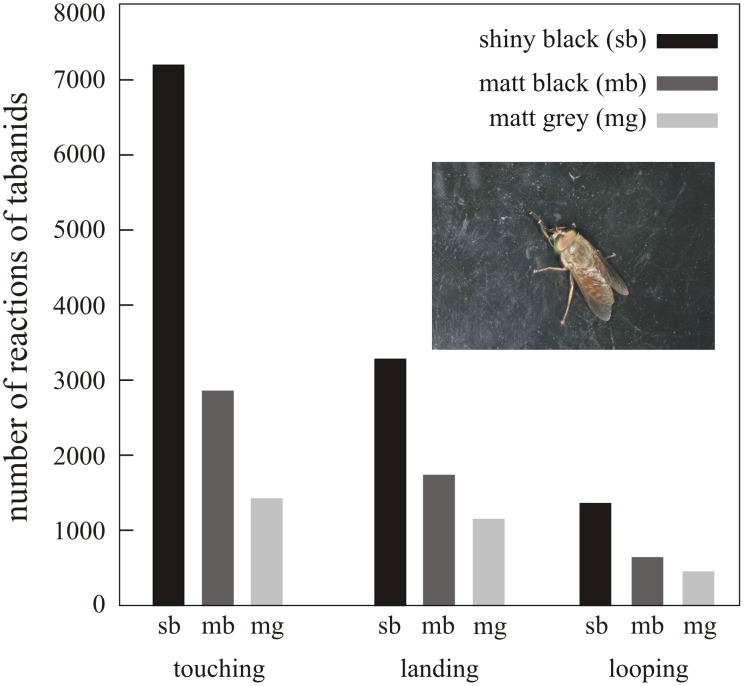
Total numbers of reactions (touching, landing and aerial looping) of tabanids to the shiny black (sb), matt black (mb) and matt grey (mg) horizontal test surfaces in experiment 2.The inset is a photograph of a tabanid fly landed on the matt grey test surface. The number of repetition is 20 (see Materials and methods, and Discussion).